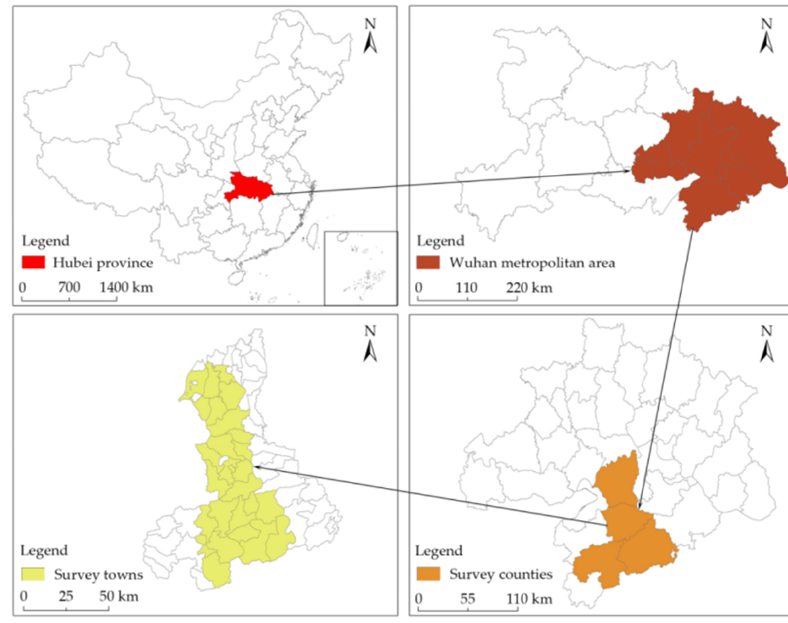
Figure 1. Study area.